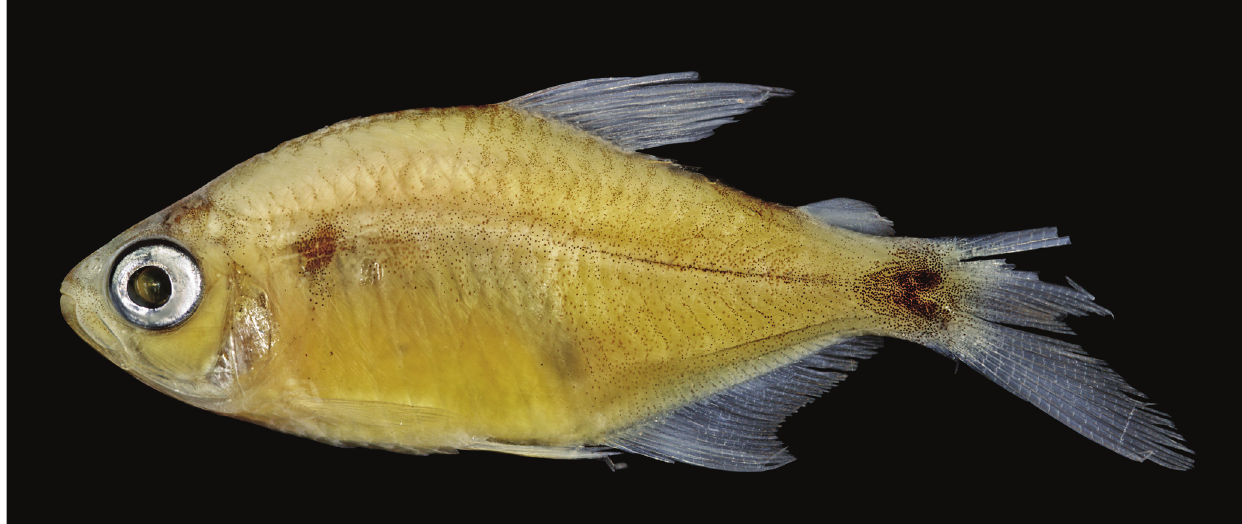
Fig. 2. Hyphessobrycon peugeoti new species, paratype, MZUSP 77734, 25.9 mm SL, female, Brazil, Mato Grosso State, rio